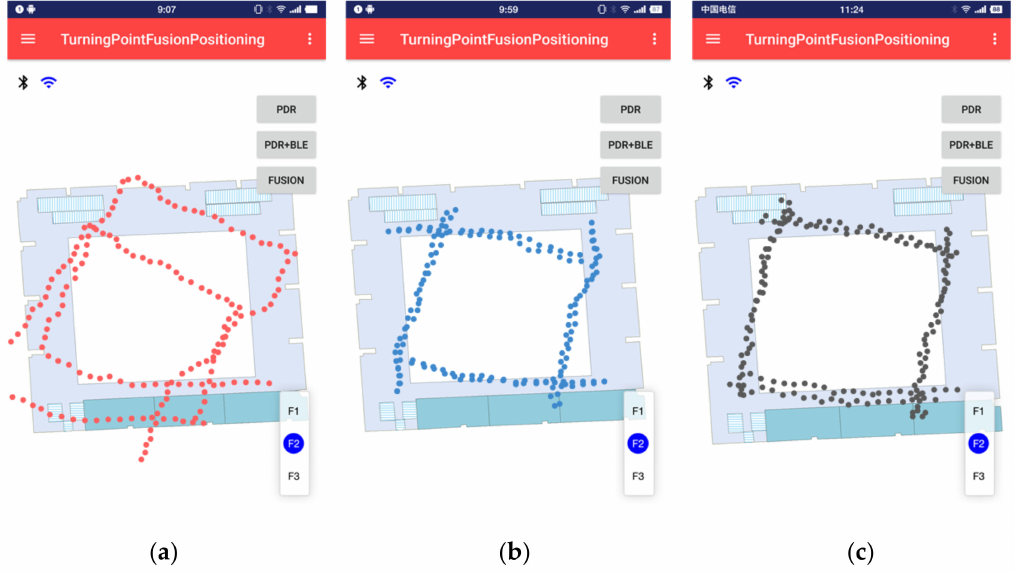
Figure 15. Positioning test results in a large-scale indoor environment: ( a ) Results of PDR positioning; ( b ) Results of Bluetooth low energy (BLE) calibration; and ( c ) Results of fusion calibration.